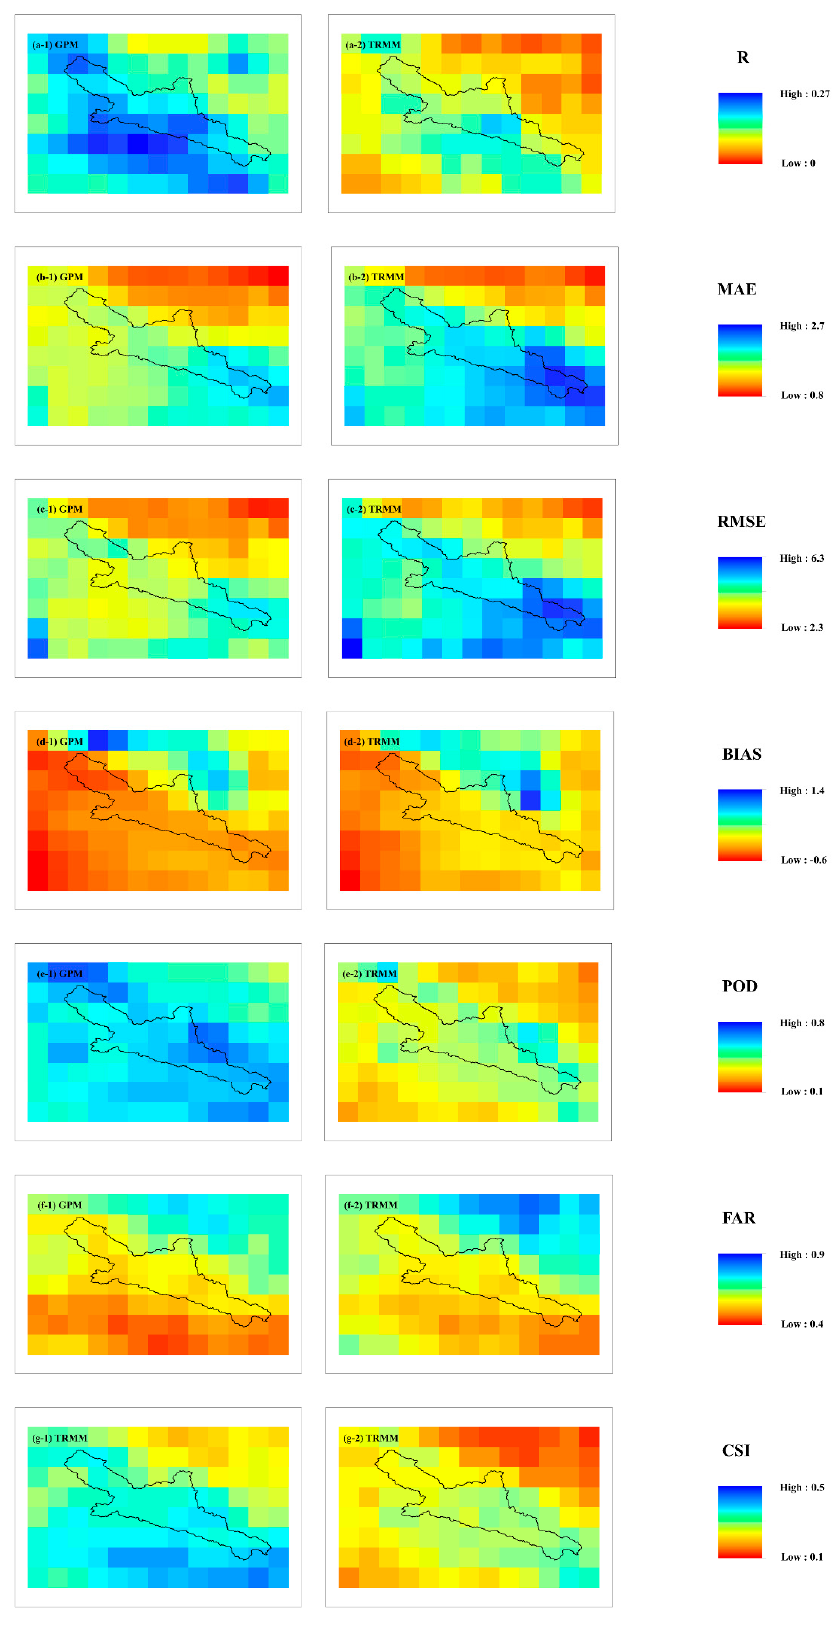
Figure 2. The spatial distribution of the seven evaluation metrics for the GPM and TRMM at the daily and grid scales ( a-1 , a-2 ) R, ( b-1 , b-2 ) MAE, ( c-1 , c-2 ) RMSE, ( d-1 , d-2 ) BIAS, ( e-1 , e-2 ) POD, ( f-1 , f-2 ) FAR, and ( g-1 , g-2 )